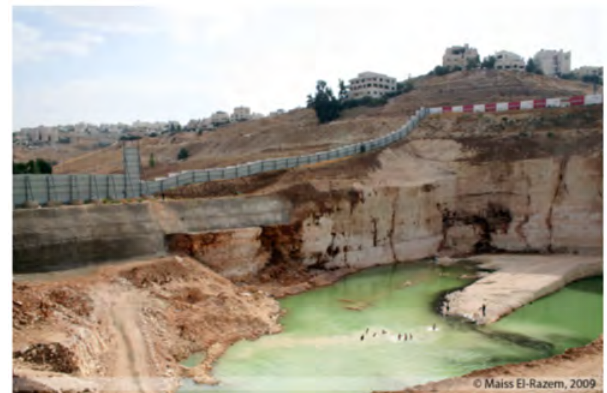
Figure 16. Sanaya Amman (Limitless towers) hole in 2009. Source: Project: Manifesto, Holes on hold competition, Maiss El-Razem (2011)